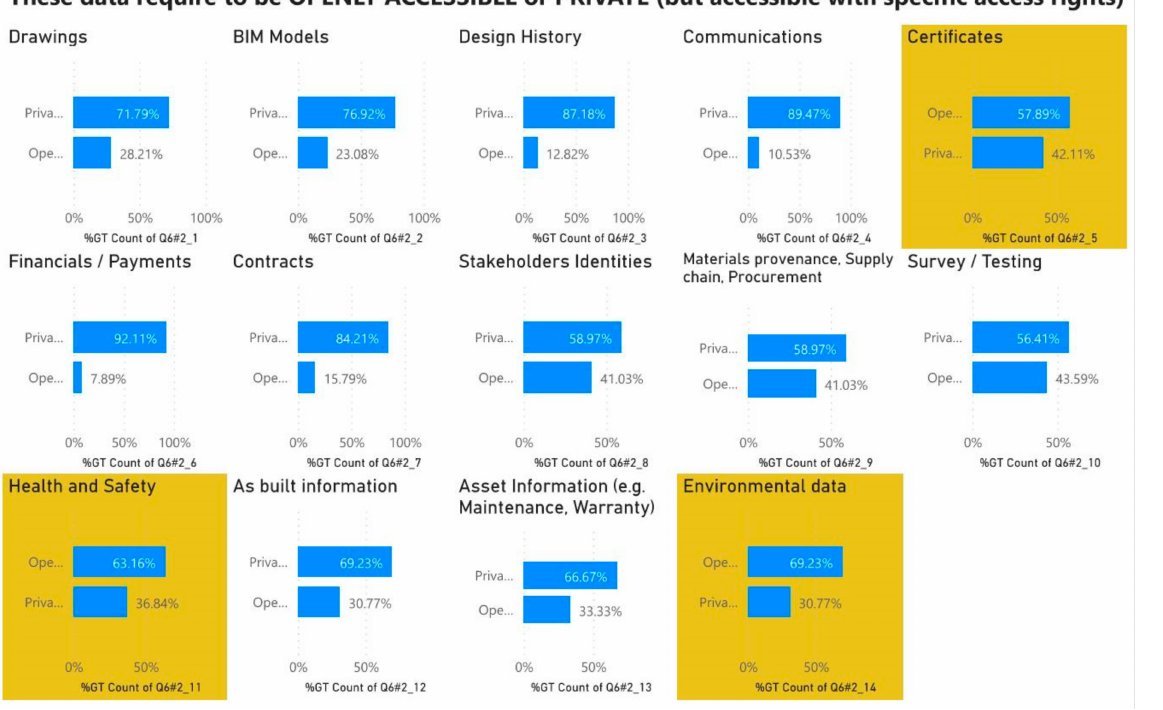
Figure 2. Overview of the answers to the online survey statement Q6-3 on data